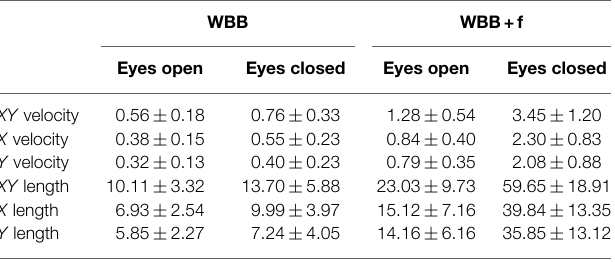
TABLE 1 | Means (cid:6) SDs of XY , X , and Y velocity (cm/s) and length (cm) for the four conditions (WBB or WBB + f, eyes open or closed) . WBB WBB+f